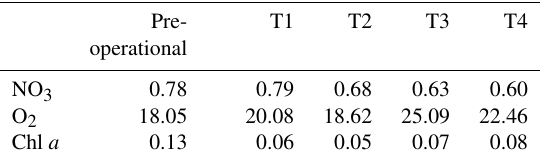
Table 6. RMSD of BGC-Argo float and model comparison for the pre-operational qualification run and for the first 4d of forecast of the Med-BIO forecast system (T1 to T4) since April 2018. Statistics are computed using the layers 0–300m for nitrate and oxygen and 0–150m for chlorophyll.